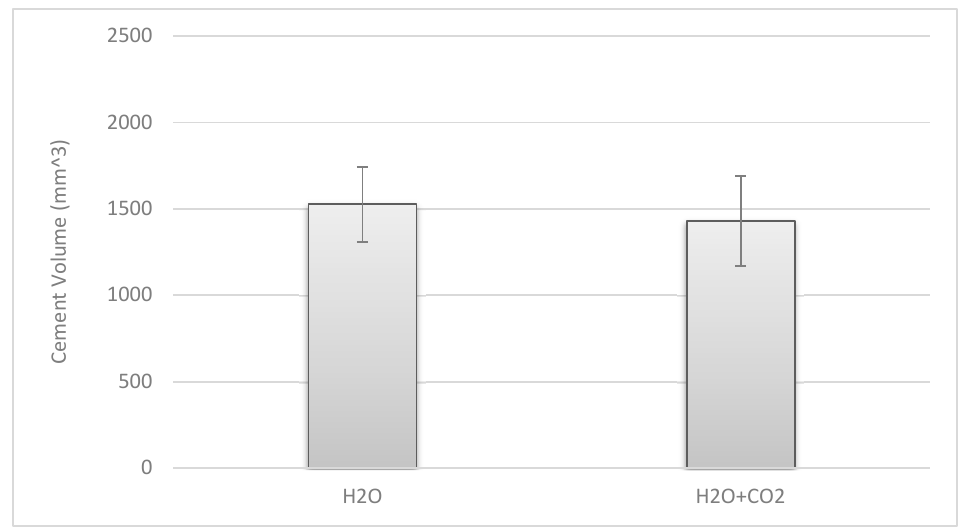
Figure 9. Cement volume penetrating the cancellous bone (Group 2-A ( left ); 2-B ( right )). No significant difference could be found with regard to the depth measurement carried out at all six representative locations (four measurement points in the plane area t(6) = 0.91, p = 0.40 (95% CI [ − 0.314, 0.685]; two measurement points beneath the peg t(6) = − 1.04, p = 0.34 (95% CI [ − 1.729, 0.700]) (Figures 7, 10 and 11).